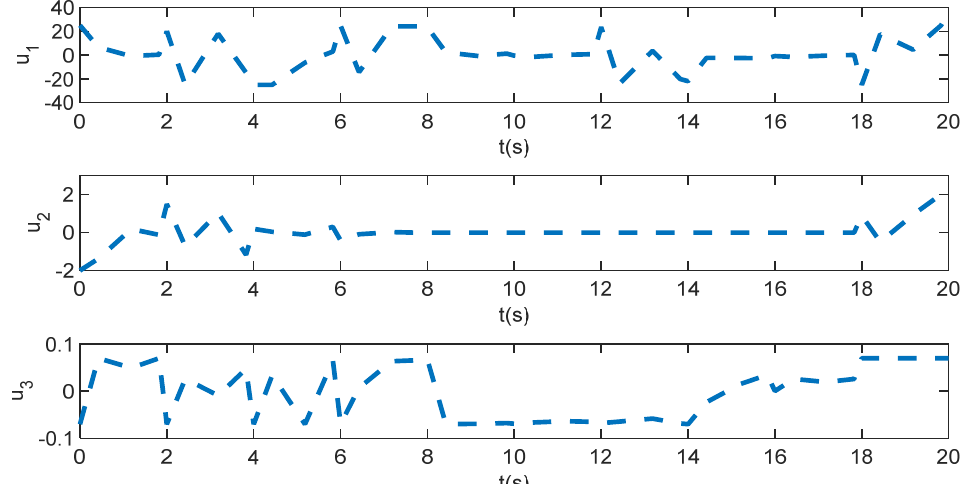
Figure 10. Control signals’ optimization results by PSM. 1 u is the cable acceleration r , 2 u is the aerodynamic coefficient rate of change L C , 3 u is the roll angle rate ψ .